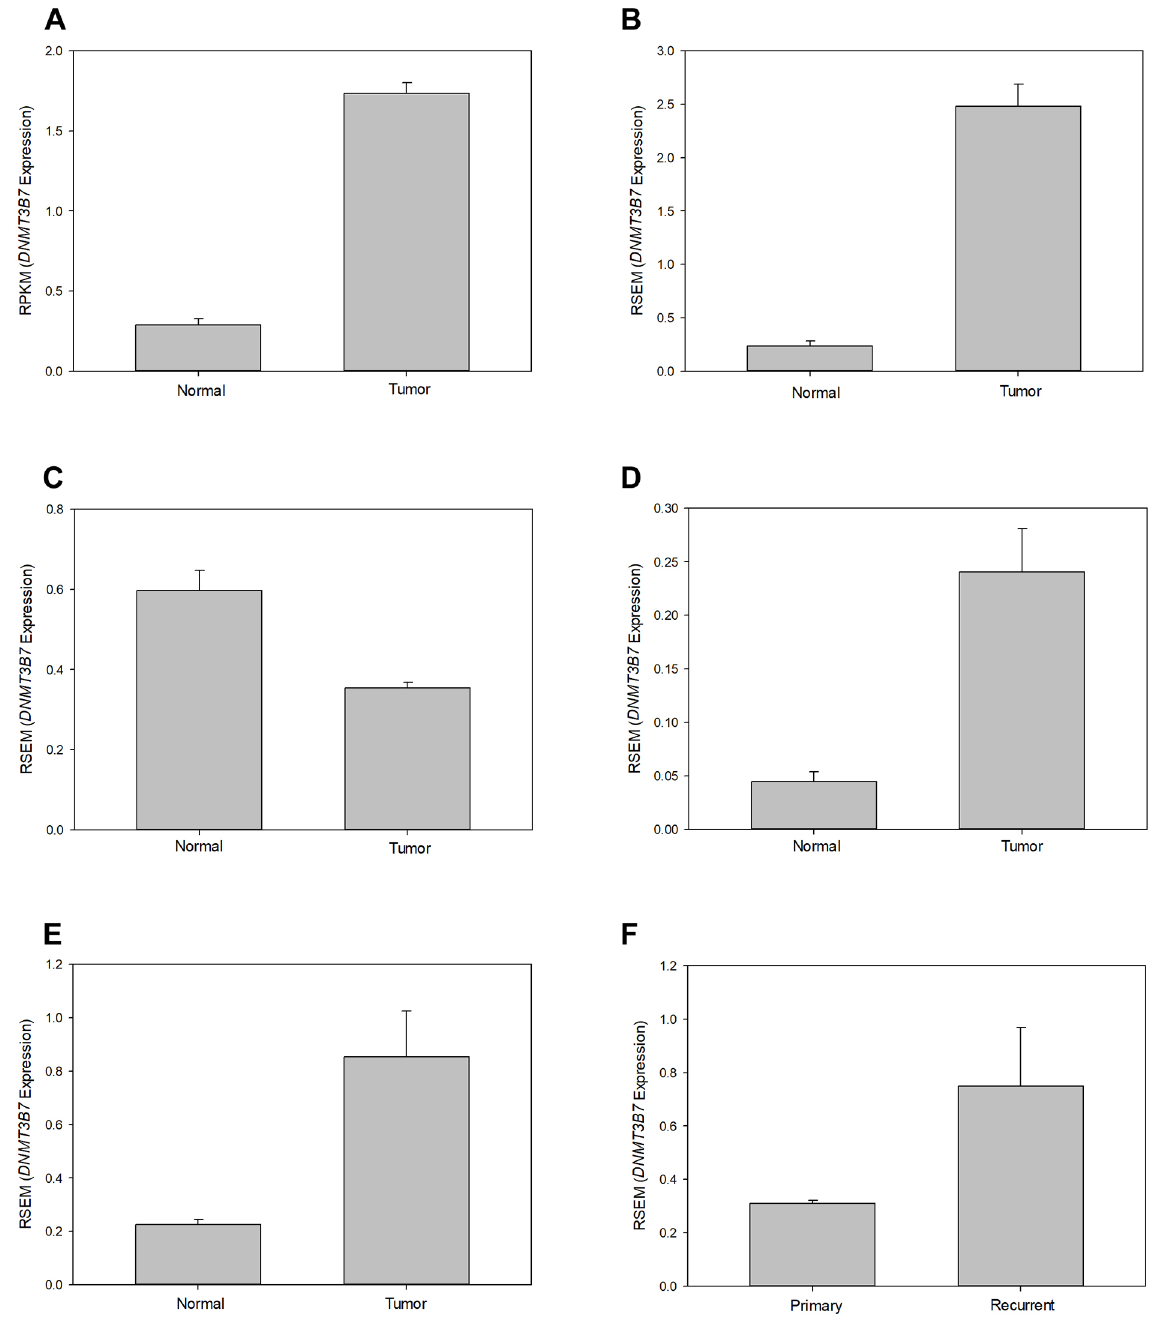
Fig 1. Expression of DNMT3B7 in normal and tumor patient samples. Representative graphs of 6 different tumor samples showing relative DNMT3B7 expression, as measured by reads per kilobase per million (RPKM) or RNA-Seq by Expectation Maximization (RSEM), in unmatched normal and tumor tissues in (A) HNSC, (B) UCEC, and (C) THCA. Expression of DNMT3B7 in matched patient samples is shown in (D) LIHC and (E) LUAD. DNMT3B7 expression in primary and recurrent tissues in (F) LGG ( p = 0.005) was assessed when normal samples were not available. All samples shown here were significant, p < 0.001, unless otherwise stated.